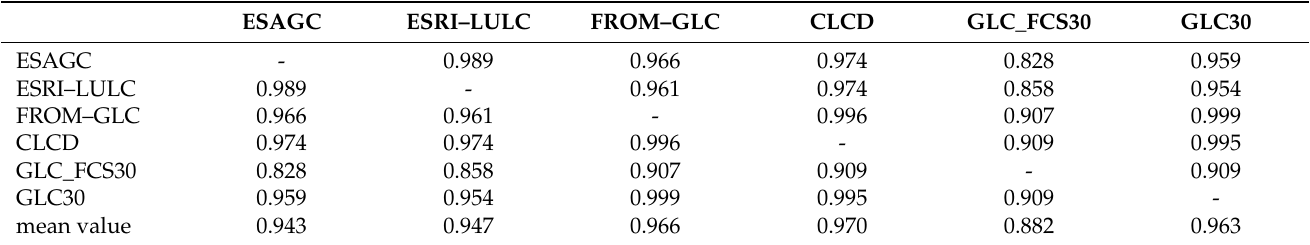
Table 3. Correlation coefficients between the six different land cover